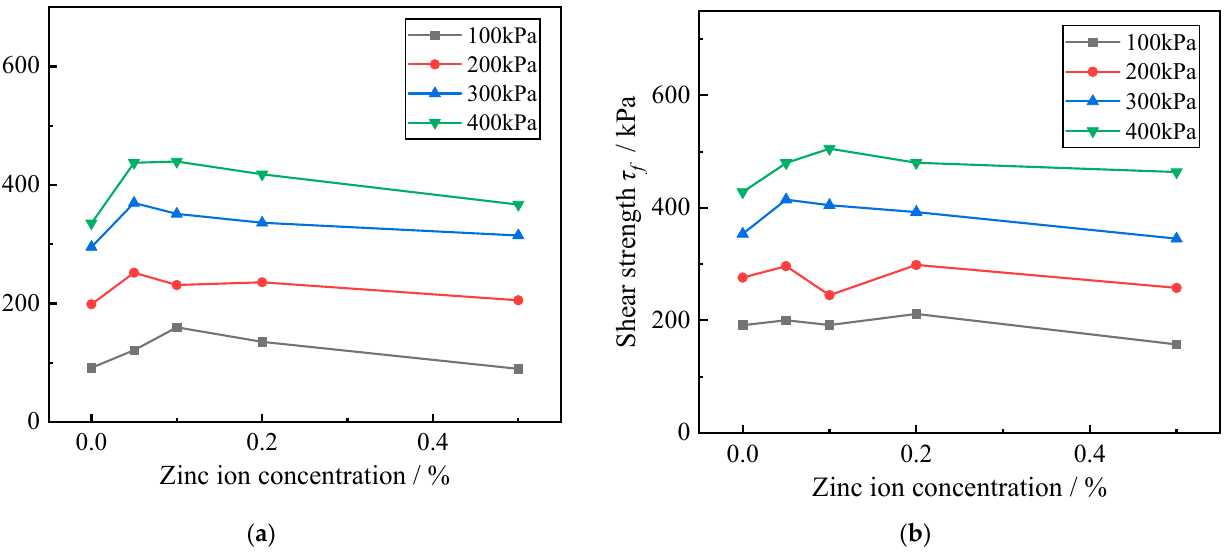
Figure 6. Influence curve of contamination concentration on shear strength of zinc-contaminated red clay. ( a ) The temperature is 8.3 °C; ( b ) The temperature is 40 °C.